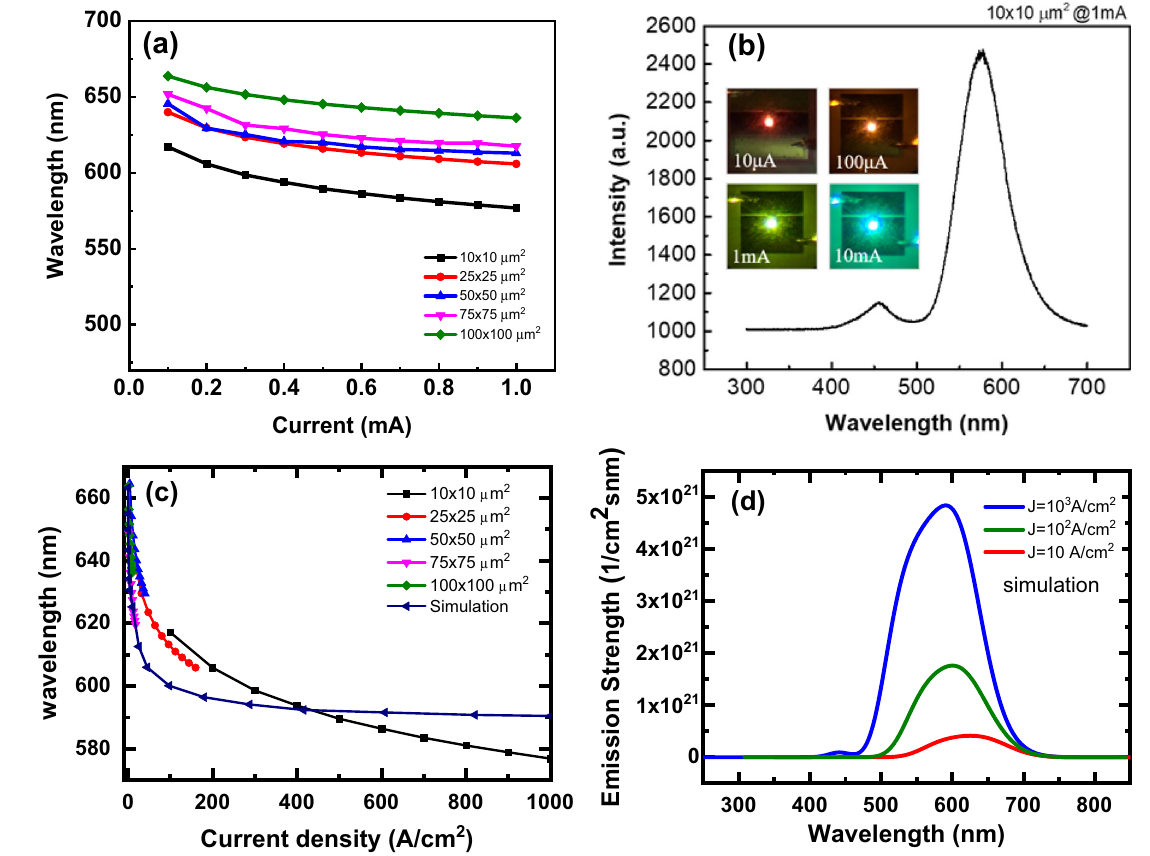
Figure 3. ( a ) Wavelength as a function of current of red μ-LEDs of different sizes under driving currents from 0.1 to 1 mA and ( b ) EL spectrum for the μ-LED with area 10 × 10 μm 2 for an injection current of 1 mA. ( c ) Wavelength shift versus current density for both experimental and simulation results and ( d ) Simulation emission spectra under different current